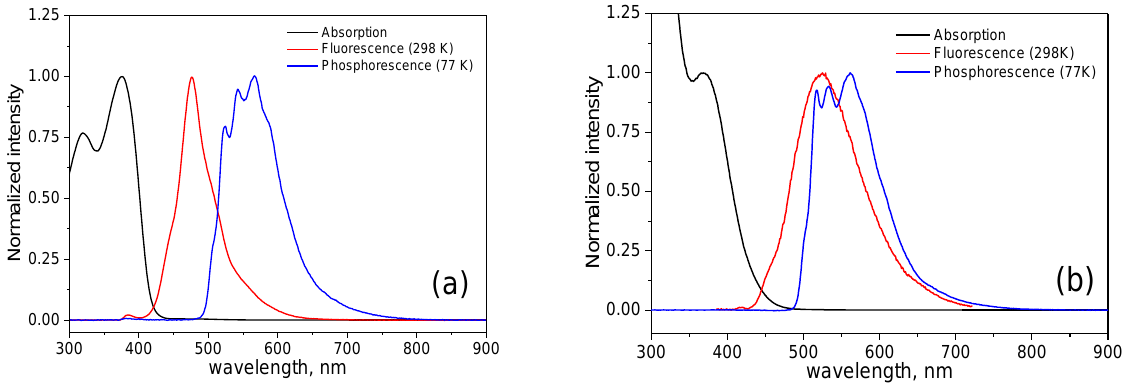
Figure 1. UV-vis absorption (black), emission (red) spectra (in benzene), and phosphorescence (blue) spectra (toluene, 77 K) for Phz1 ( a ) and Phz2 ( b ). The λ max for the absorption peaks were close (376 nm for Phz1 and 370 for Phz2 ); these were similar to the value (369 nm) for the S 0 → S n excitation predicted for the unsubstituted N , N -diphenyldihydrophenazine [17]. The molar absorptivity ε was greater for Phz1 (4499 vs. 3800 for Phz2 in benzene), thereby making the S 0 → S n transition more probable. The emission spectra of the compounds were significantly different. The emission band for Phz2 was broader, redshifted ( λ max was 476 nm and 523 nm for Phz1 and Phz2 , respectively), and exhibited a much higher Stokes shift (177 nm for Phz2 and 99 nm for Phz1 ), which indicated that the origin of the emission was based on the intramolecular charge transfer between the donor and acceptor units. A much higher Stokes shift for Phz2 was attributed to a relaxation of the excited electron resulting in the LUMO having a lower energy due to the electron-withdrawing CF 3 substituents, which was in contrast to the t-Bu groups in Phz1 increasing the LUMO level. The emission spectrum for Phz1 was insensitive to the solvent polarity, whereas a significant solvatochromic effect